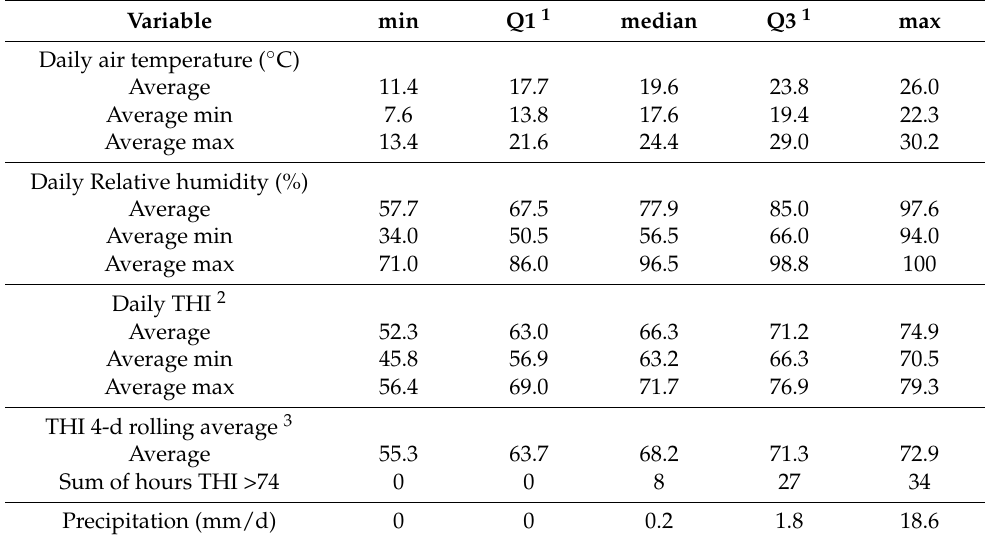
Table 1. Description of weather data during the study